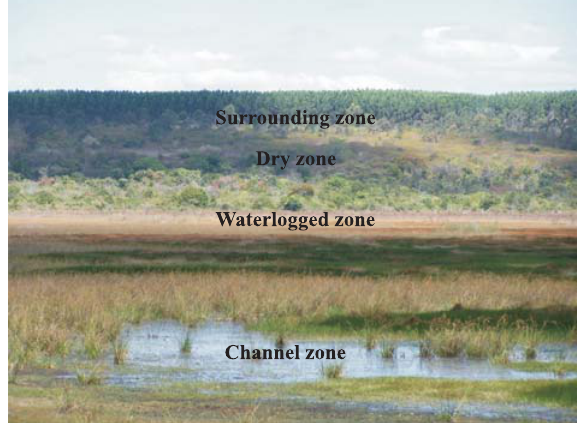
swamp.Figure 2. Zones in the microbasin of the Lagoa do Leandro swamp, differentiated by vegetation, soil, and